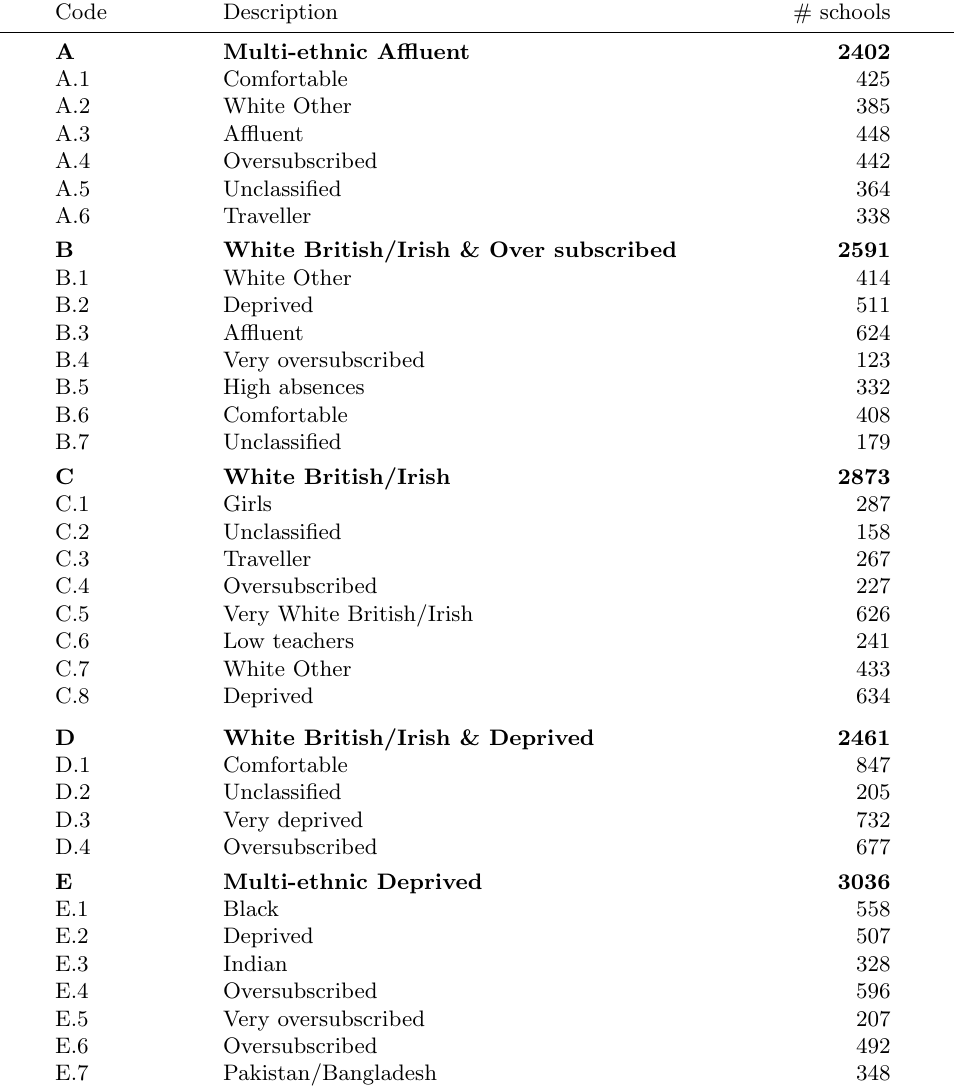
Table 3: Names for the